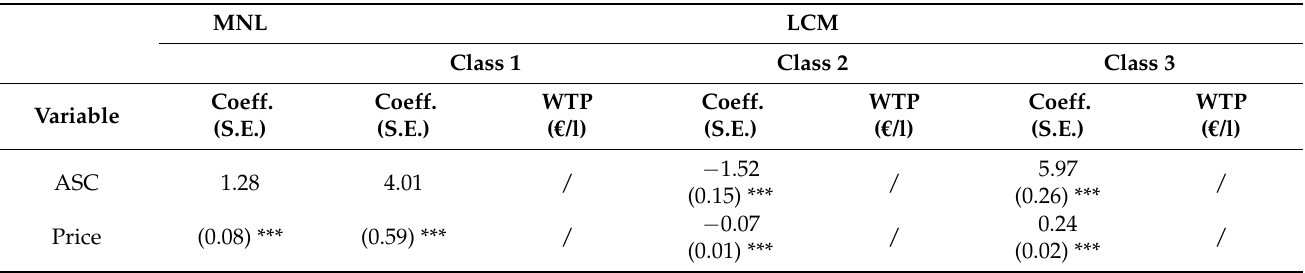
Table 3. MNL and LCM